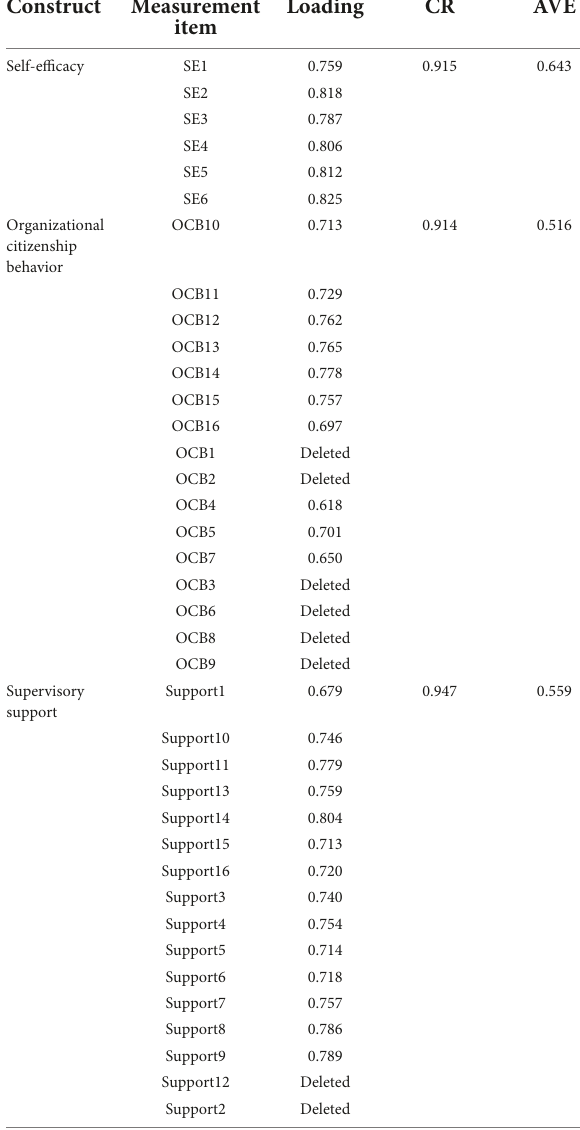
TABLE 2 Internal consistency reliability and convergent